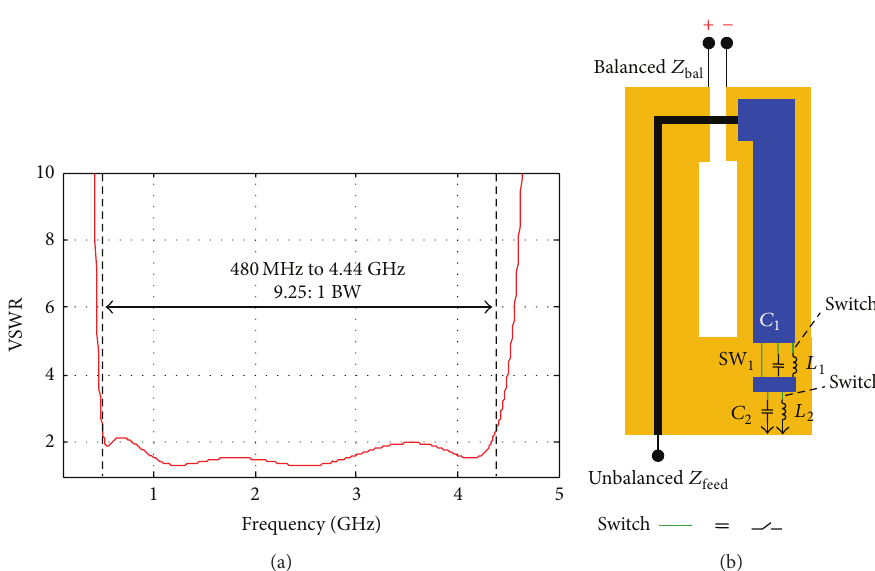
Figure 20: MTM array bandwidth reconfiguration by varying the loads at the termination of the open stub. For the VSWR response to the left stub it is simply left open, implying SW1 is open and 𝐶 2 /𝐿 2 are off (unconfigured case). The other parameters: 𝑍 = 188.5 Ω , 𝐿 = 2.2 nH, 𝐶 = 2.3 pF, ℎ = 60 ∘ , ℎ = 90 ∘ , characteristic impedance of 𝑍 𝑍 Sup sup dipole coupling sub = 312 Ω , 𝑙 = 58 ∘ with all electrical lengths given at 2.5 impedance of 𝑍 SC SC